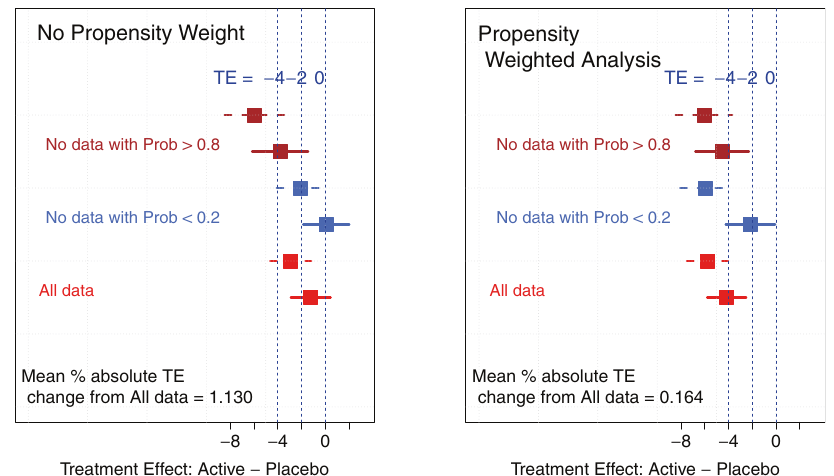
Fig. 4 Sensitivity analysis. Propensity weighed and non-weighted analyses: comparison of the estimated TE in the total population (All data) and in population without high (Prob > 0.8) and without low (Prob < 0.2) placebo response. The dots represent the TE value estimated in the MMRM analysis, the horizontal lines represent the 95% con fi dence intervals (the solid lines correspond to the 12.5 mg arm and the dotted lines corresponds to the 25 mg arm). The vertical blue dotted lines represent some reference TE values of − 4, − 2, and 8 weeks duration, fi xed-dose study to evaluate the clinical ef fi cacy